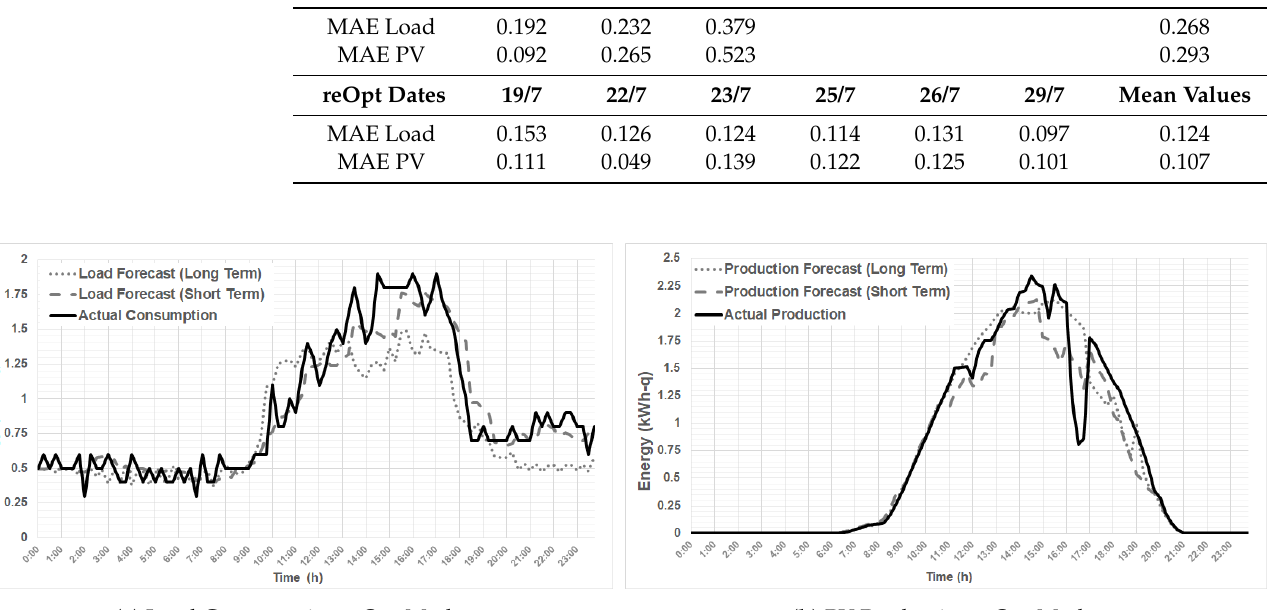
Figure 4. Scenario A—Optimisation mode on 15/7: consumption/generation.